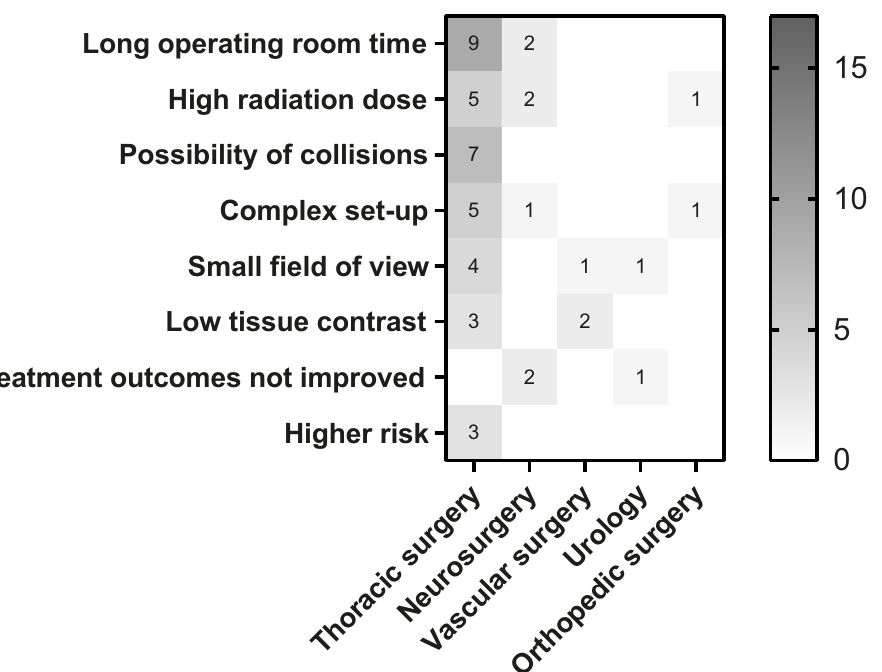
Fig 4. Overview of the challenges mentioned by the studies per clinical discipline. The numbers and grayscale indicate how many studies mentioned the challenge.